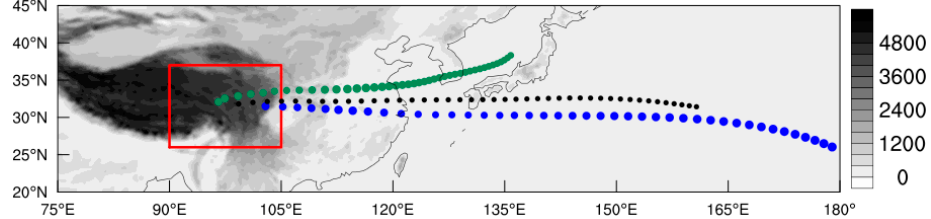
Figure 5. Horizontal forward trajectories of the released particles determined by cluster analysis from 0600 UTC 15 March 2006 to 0000 UTC 17 March 2006. Green dots and blue dots represent the two cluster analysis trajectories. Black dots represent the trajectory of the total mass center. The terrain height (unit: m) is shaded.